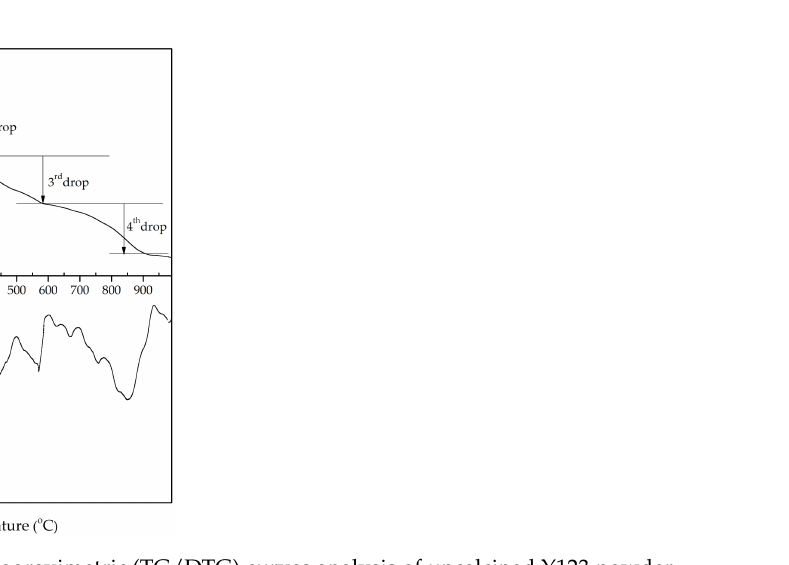
Figure 1. Thermogravimetric (TG/DTG) curves analysis of uncalcined Y123 powder.